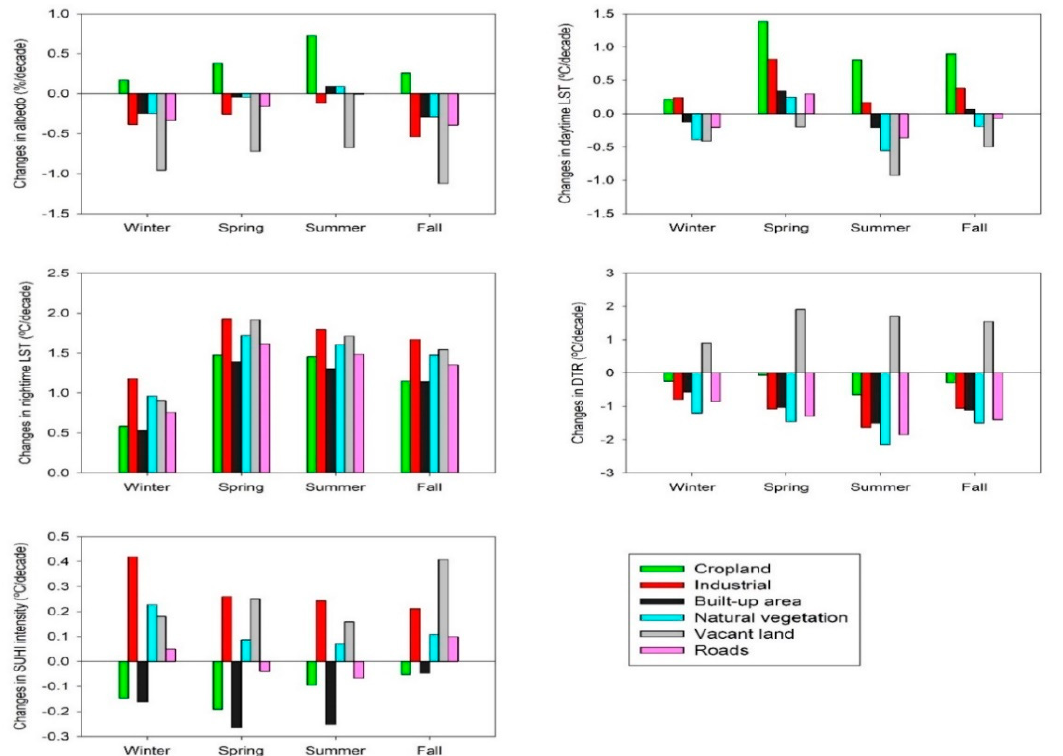
Figure 12. Amount of change in the different environmental and climatic variables, as a function of the dominant LCLU types in Greater Cairo. Changes in the intensity of SUHI as a function of these types are also presented.